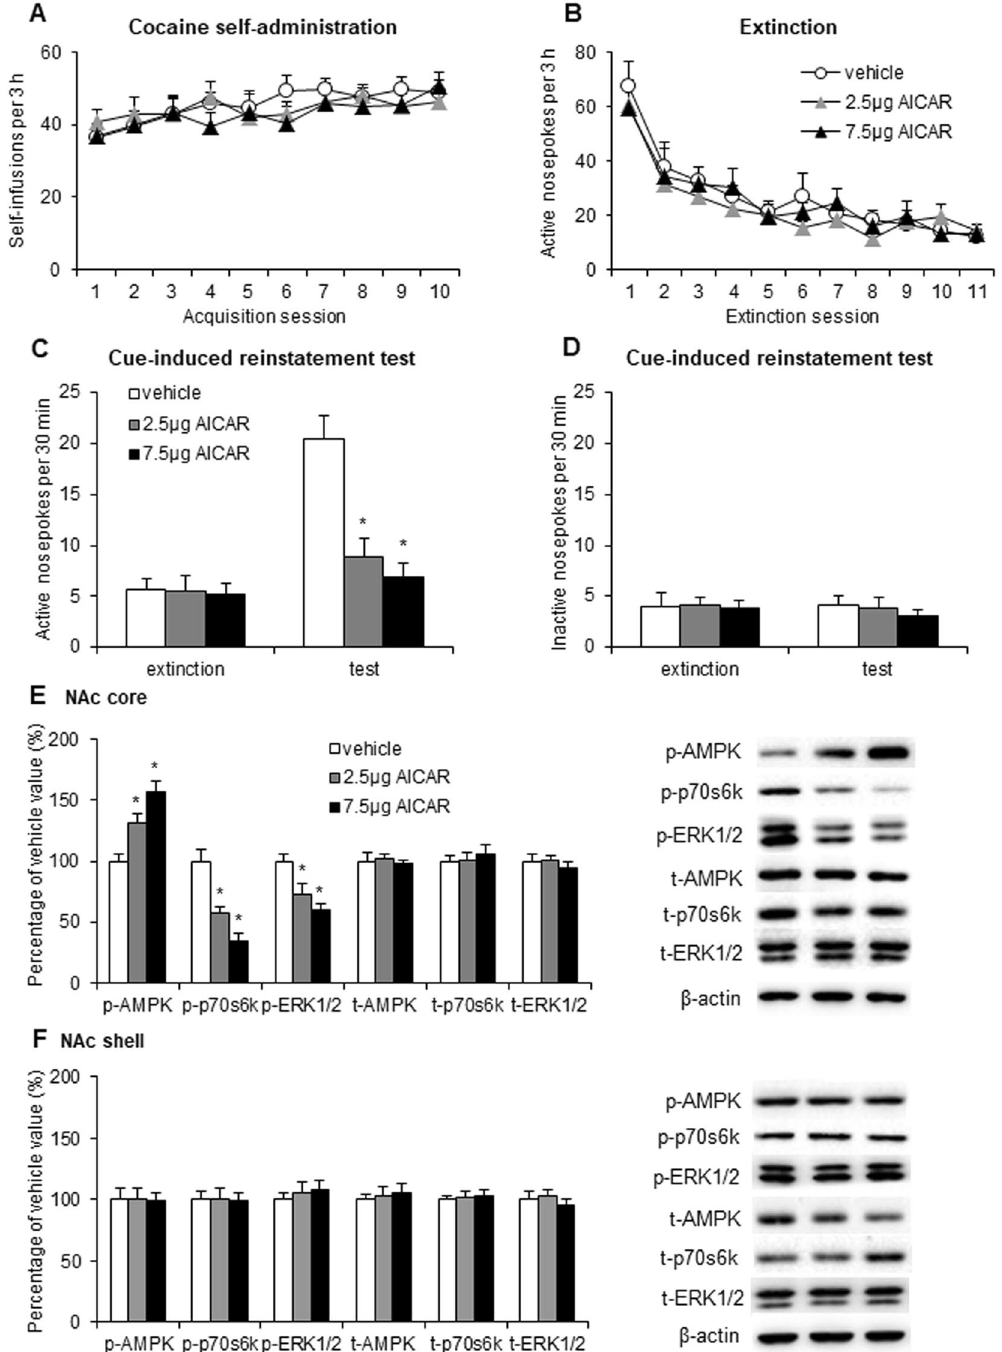
Figure 2. Activation of AMPK activity in the NAc core decreased the cue-induced reinstatement of cocaine seeking and inhibited mTORC1 and ERK1/2 signaling. ( A ) The number of self-infusions during daily 3-h sessions increased in the cocaine self-administration groups ( n = 9 per group). ( B ) Responding during daily 3-h extinction sessions decreased in the cocaine groups. ( C , D ) Average active or inactive nosepoke responding during a 30-min cue-induced reinstatement session before which the rats received intra-NAc core infusions of vehicle or AICAR (2.5 or 7.5 μ g/side). ( E , F ) Percentage of phosphorylated AMPK, phosphorylated p70s6k, phosphorylated ERK1/2, total AMPK, total p70s6k, and total ERK1/2 in the NAc core and shell relative to the vehicle group and representative Western blots ( n = 9 per group). The data are expressed as mean ± SEM. * p < 0.05, compared with vehicle